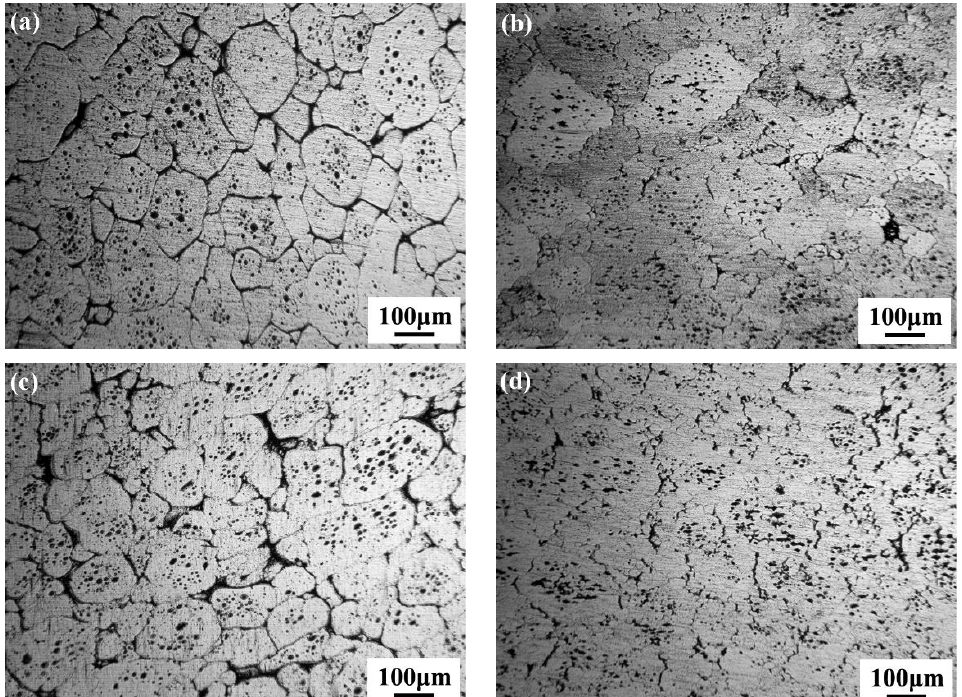
Figure 5. Metallographic diagram of different positions of the deformed part prepared at different deforming temperatures: ( a ) located at the edge and holding at 620 °C; ( b ) located at the centre and holding at 620 °C; ( c ) located at the edge and holding at 630 °C; ( d ) located at the centre and holding at 630 °C.